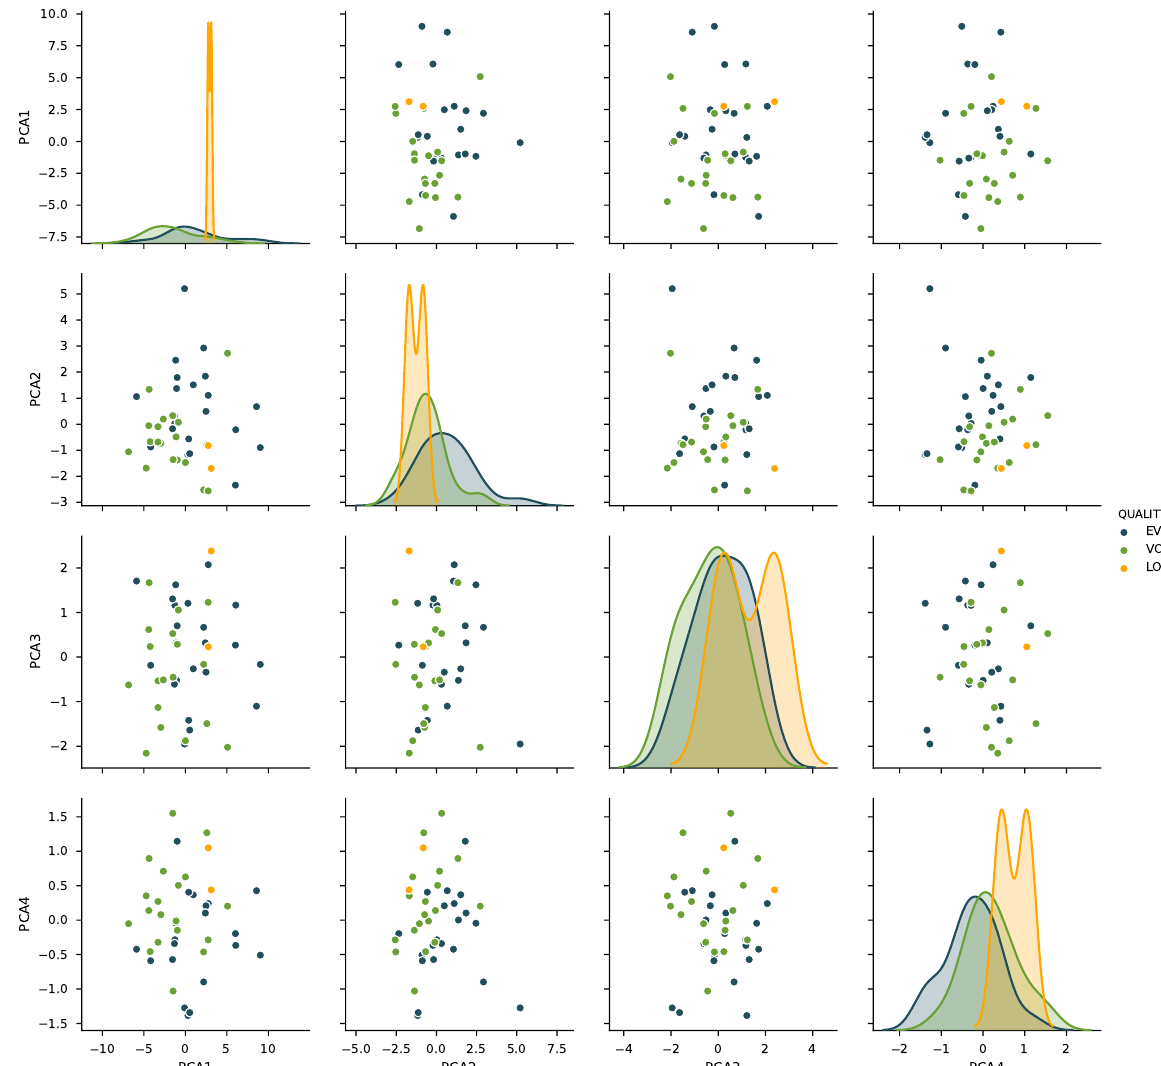
Figure 4. Visualization of the four first PCA components, computed for the whole